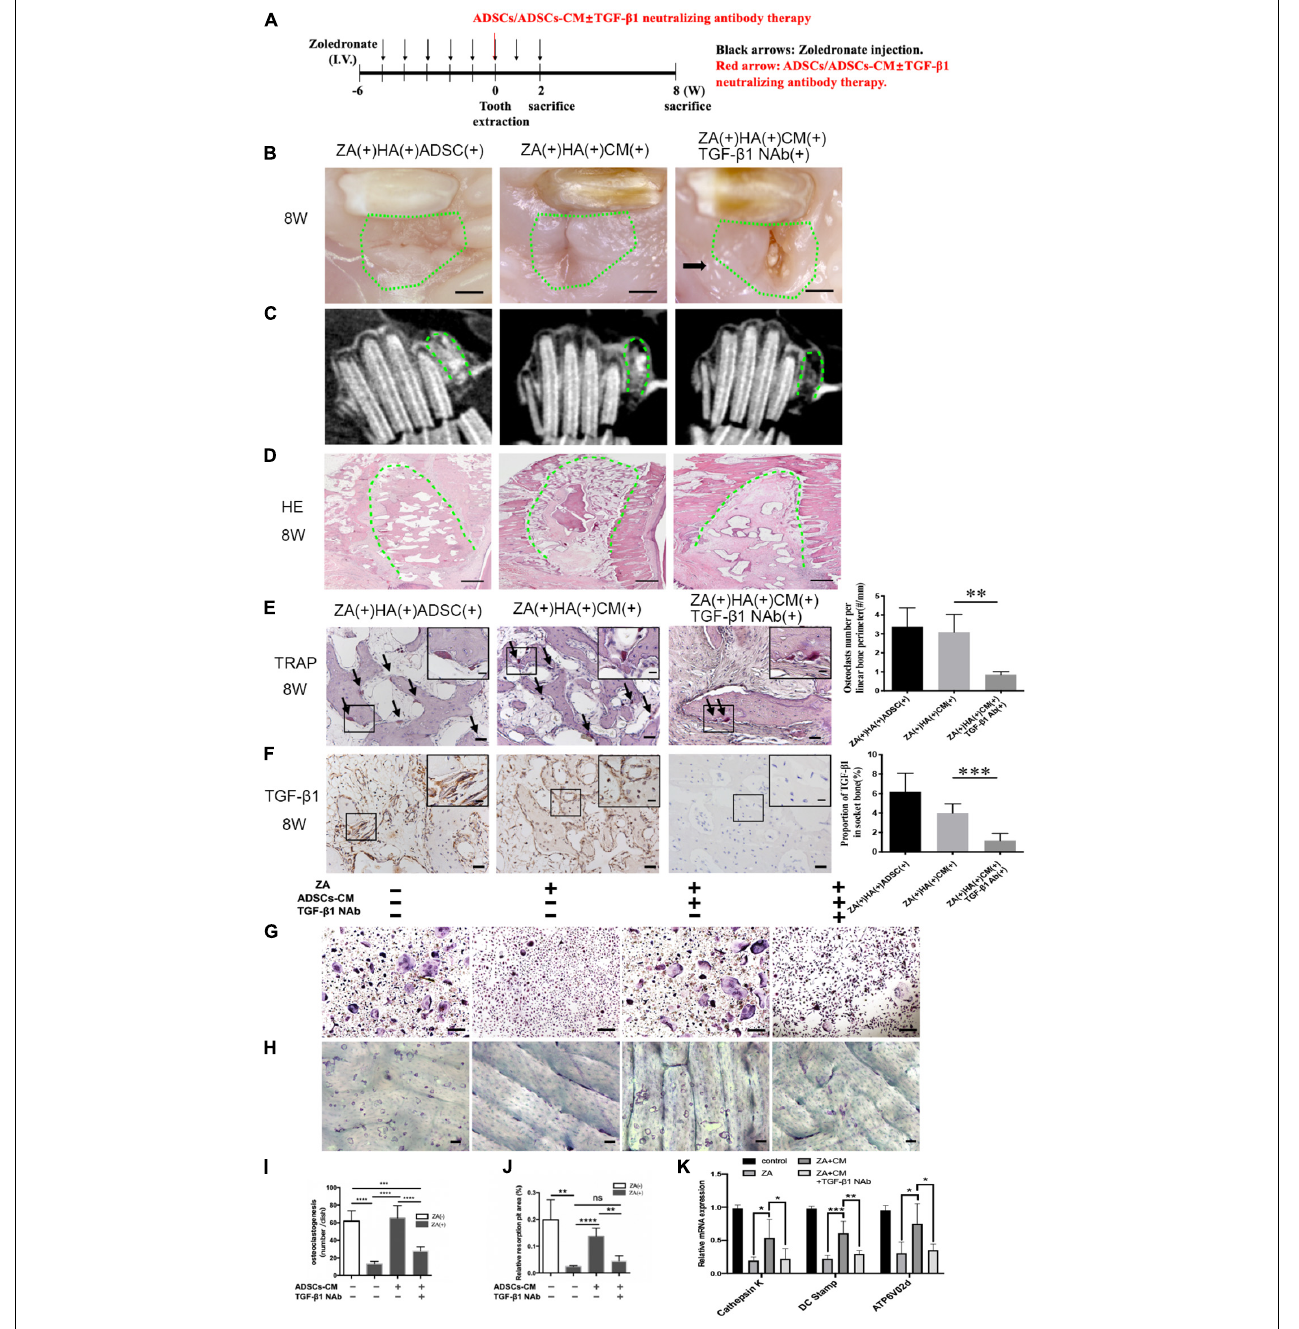
FIGURE 3 | Inhibition of TGF- β 1 attenuates ADSCs promoted osteoclastogenesis and BRONJ healing. (A) Schematic diagram of ADSCs-CM with or without TGF- β 1 neutralizing antibody therapy. Rabbits were i.v. injected with zoledronate (800 µ g/kg, black arrows) 6 weeks before tooth extraction and ADSCs-CM ± TGF- β 1 neutralizing antibody (red arrow) treatment followed by zoledronate injection for 2 weeks. (B) Representative image of extraction sites 8 weeks after tooth extraction. Green circles represent images of the extraction site, and black arrows point to the exposed alveolar sockets. Bar: 1 mm. (C) CBCT images of each group. (D) Bone tissues in alveolar sockets (green dot line) were detected by H&E staining and the extent of bone tissue fraction. Bar: 1 mm. (E) TRAP staining in sockets at 8 weeks post-tooth extraction. Black arrows indicate osteoclasts. Insets show magnified boxed region. Bar: 50 µ m, bar of magnified image: 20 µ m. (F) IHC of TGF- β 1 expression in alveolar sockets. Bar: 50 µ m, bar of magnified image: 20 µ m. (G) TRAP staining patterns of osteoclasts are shown in vitro and (I) quantitative analysis of the osteoclasts number. And (H) staining of bone resorption areas on bovine bone slices and (J) quantitative analysis of bone resorption pits. (K) Quantification of osteoclast differentiation-related gene expression in each group. ADSC( ± ), adipose-derived stem cells-treated or -untreated; CM( ± ), ADSCs condition medium-treated or untreated, and TGF- β 1 NAb( ± ), ADSCs-CM with TGF- β 1 neutralizing antibody-treated or -untreated. ∗ p < 0.05, ∗∗ p < 0.01, ∗∗∗ p < 0.005, ∗∗∗∗ p <